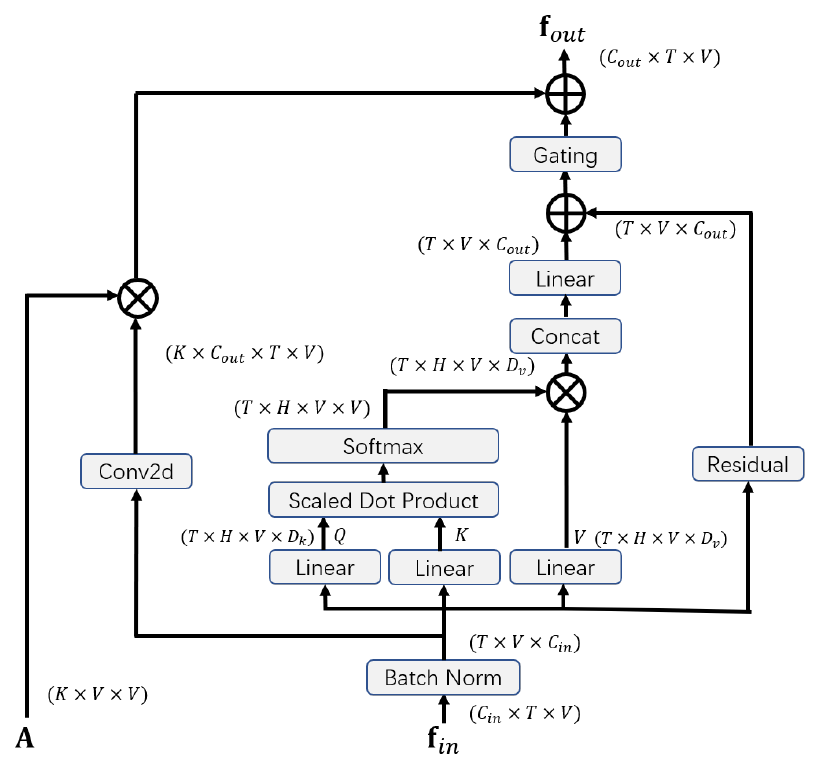
Figure 2. Illustration of self-Attention enhanced spatial graph convolutional layer. For each timestep in one sample, we represent the feature vector of each joint as a i ∈ R